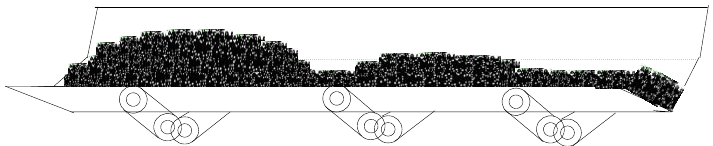
Figure 3. The non-uniform bulk material distribution in actual operation.